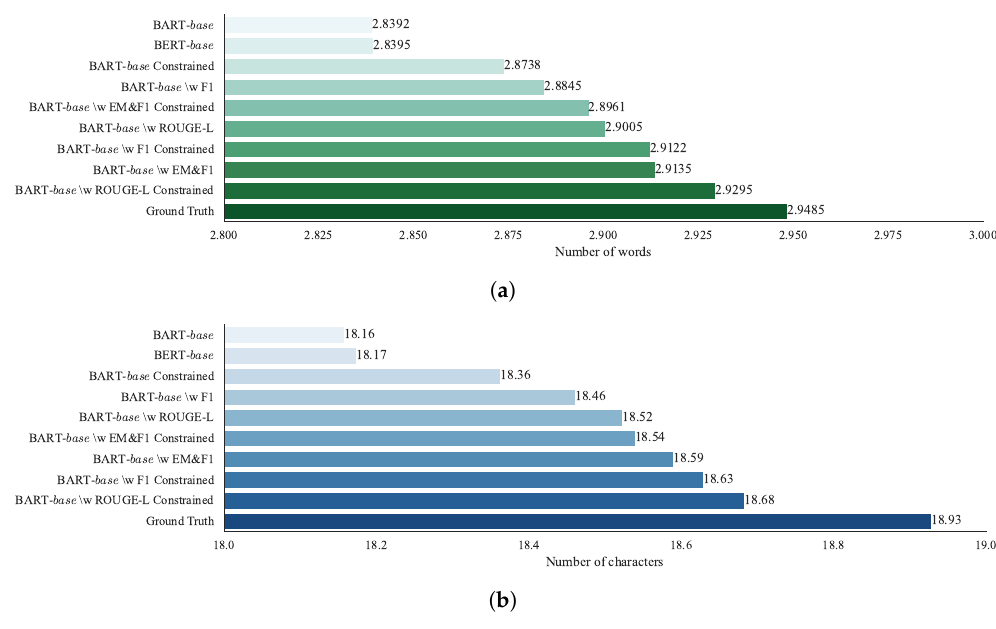
Figure 4. The average length of the answers predicted by the models. ( a ) The numbers of words in the answers. ( b ) The numbers of characters in the